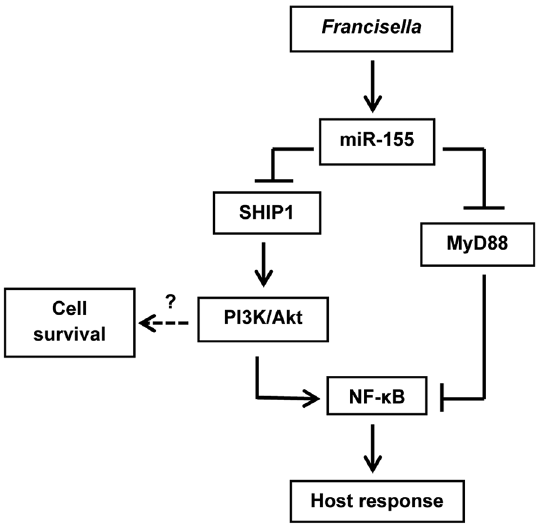
Figure 8. Model of miR-155-mediated regulation of the inflammatory response during F.tularensis infection. F. tularensis lipoproteins trigger TLR2 signaling in macrophages [4], which results in the MyD88-dependent upregulation of miR-155 by 18 h post-infection (Fig. 2). This microRNA is part of a negative feedback loop that confers downregulation of MyD88 and SHIP-1 by translational repression (Fig. 3). Loss of MyD88 impairs further TLR2 and IL-1 receptor signaling, and as such curtails inflammation, including TNF a secretion (Fig. 7).